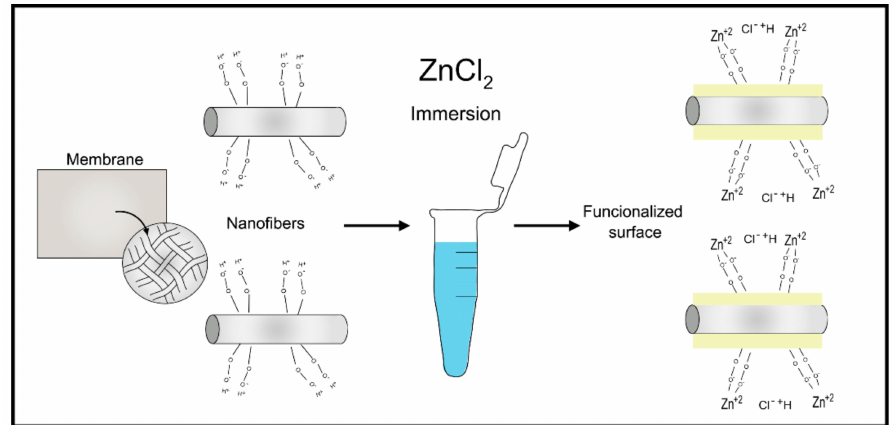
Figure 2. The carboxyl-terminal on polymeric Zinc-doped membranes surfaces, after their immersion on ZnCl 2 .